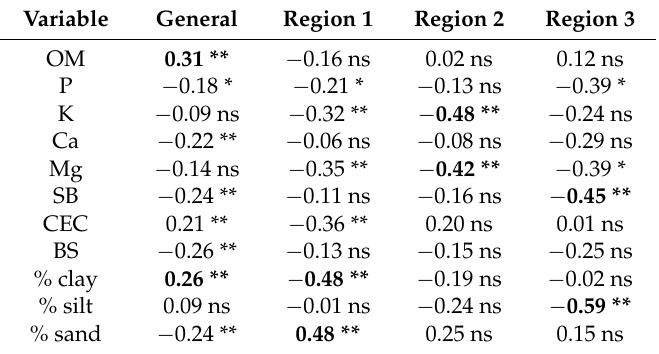
Table 6. Pearson’s coefficient relating fertilization response and soil variables.